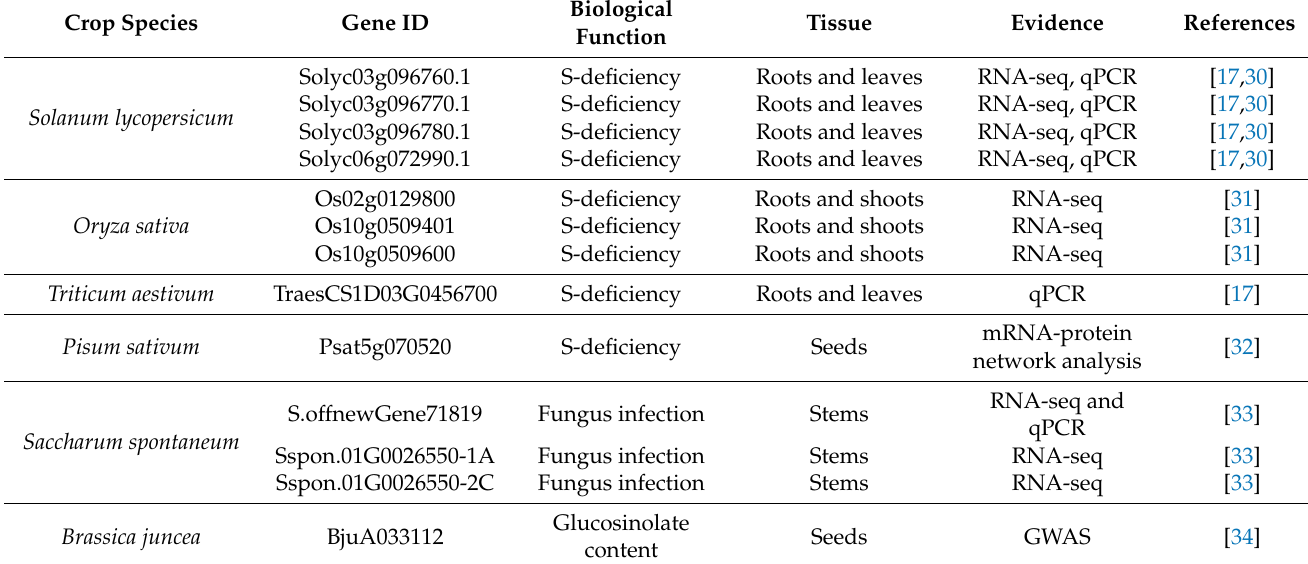
Table 1. List of crop species with experimental evidence for LSU